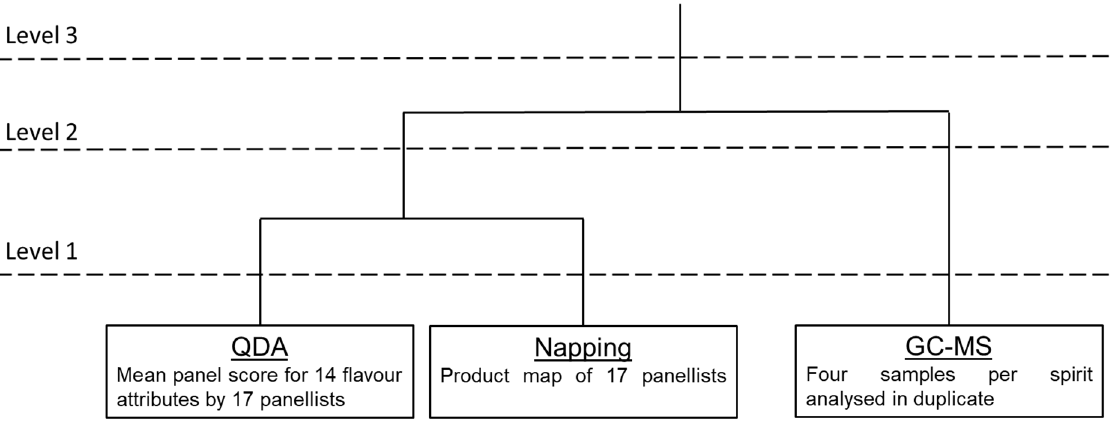
Figure 1. Levels of the HMFA grouping.